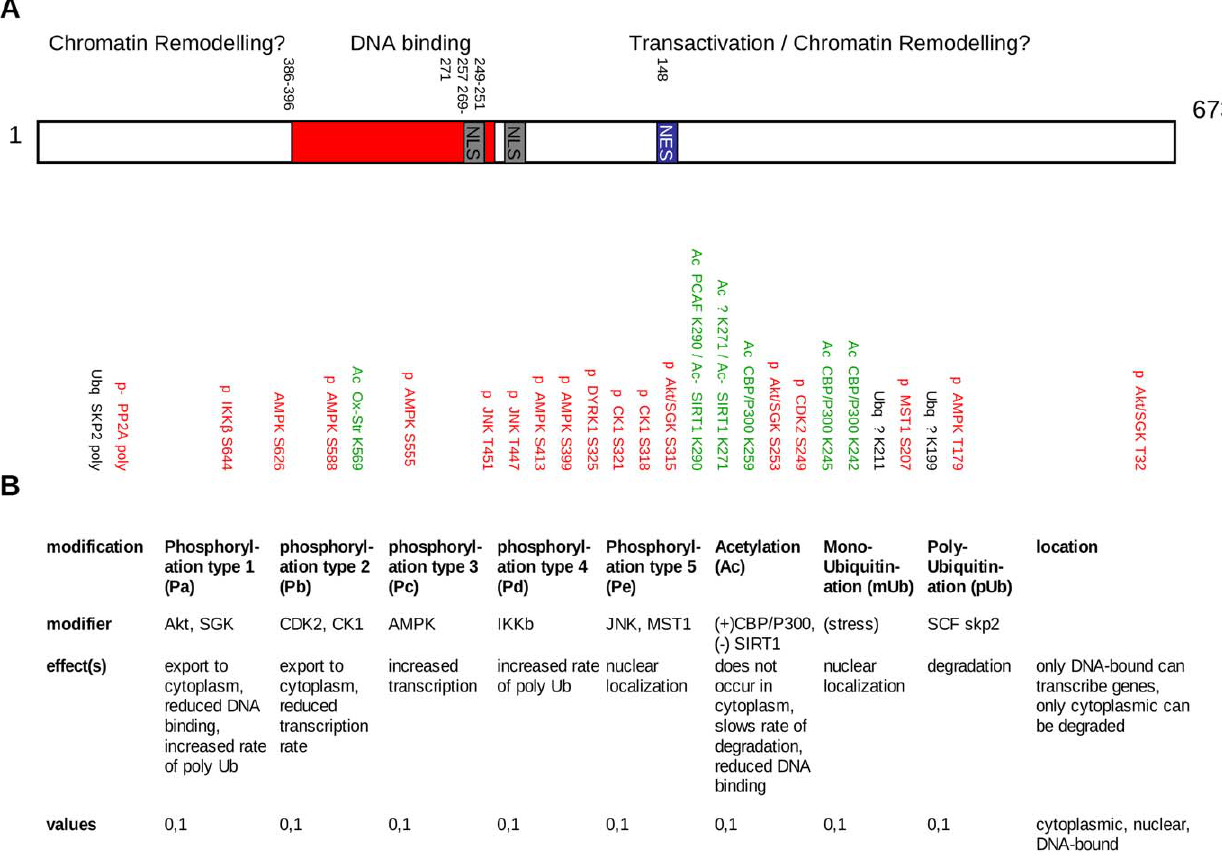
Figure 2. Summary of FOXO PTMs. A: Sites and types of PTMs; and modifying enzymes; based on figure 2 of Calnan and Brunet 2008 [54]. B: Simplified set of collective PTMs and their effects.